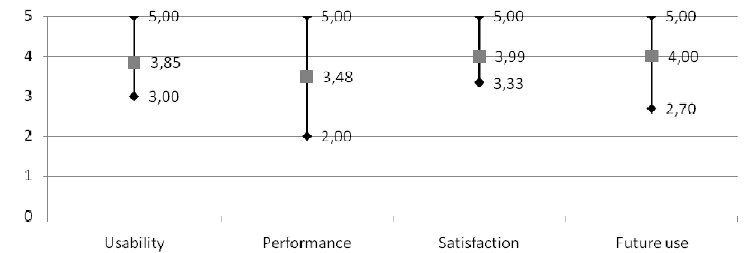
Figure 10. Usability, performance, satisfaction and future use